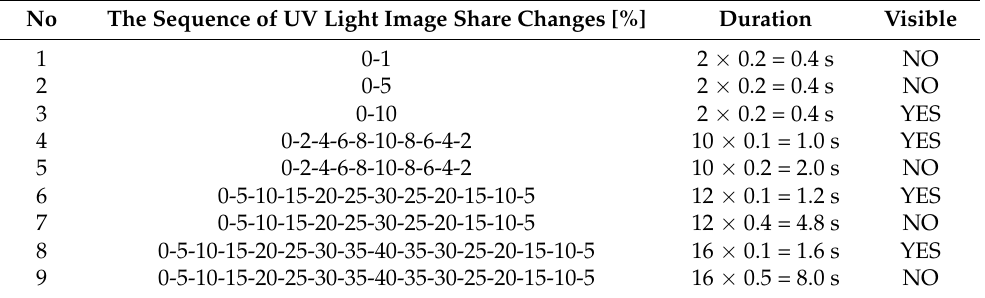
Table 4. Patterns and visibility of simulated UV light modulation. Rows 1–3 reflect square waves and rows 4–9 approximate triangle waves with equal steps. For instance, the first row describes switching between 0 and 1% UV light share of 0.2 s each, resulting in a cycle duration of 0.4 s.